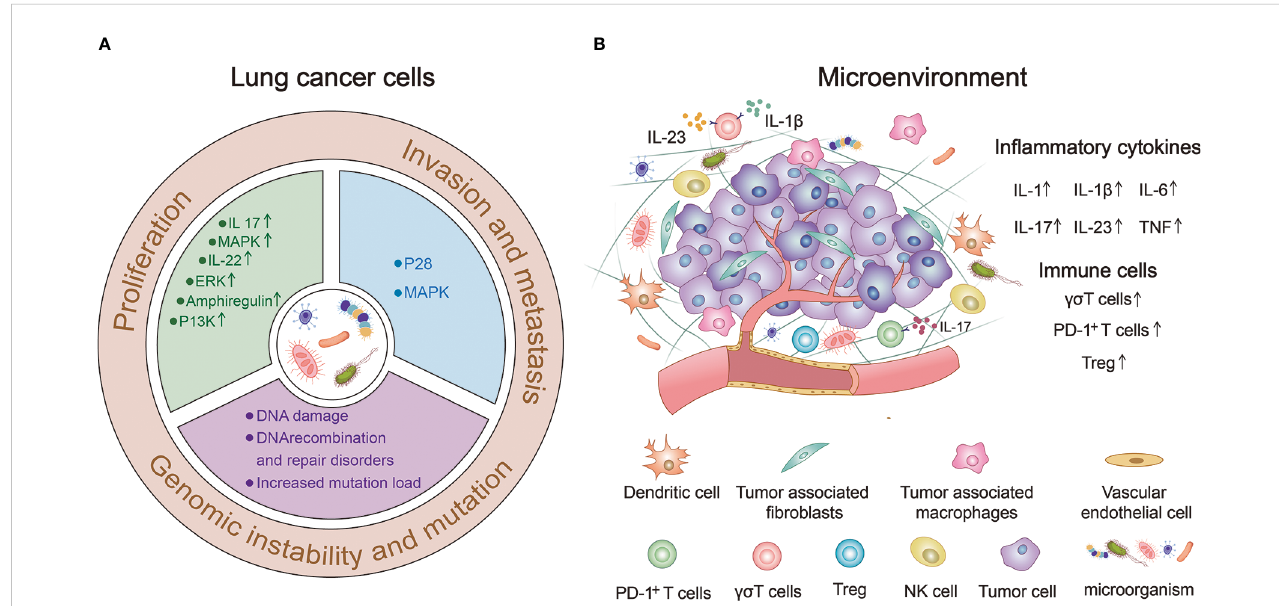
FIGURE 2 The human microbiome can signi fi cantly in fl uence the occurrence and progression of lung cancer. (A) Human microbiota can directly or indirectly affect the proliferation, invasion, metastasis, genomic instability and mutation of lung cancer cells. (B) Human microorganisms participate in the composition of lung cancer microenvironment (TME) and regulate the occurrence and development of lung cancer by up-regulating the expression of immune cells and in fl ammatory